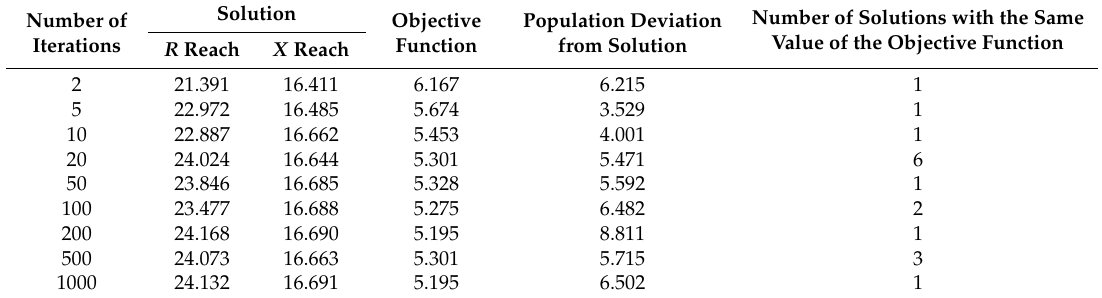
Table 4. Performance tests of the GA with a preference factor k = 0.8 and a mutation rate of 0.1. Solution Objective Number of Population Deviation Iterations Function from Solution